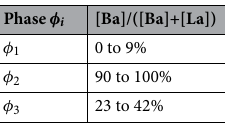
Table 1. Phases observed over the BaS- La 2 S 3 pseudo-binary phase